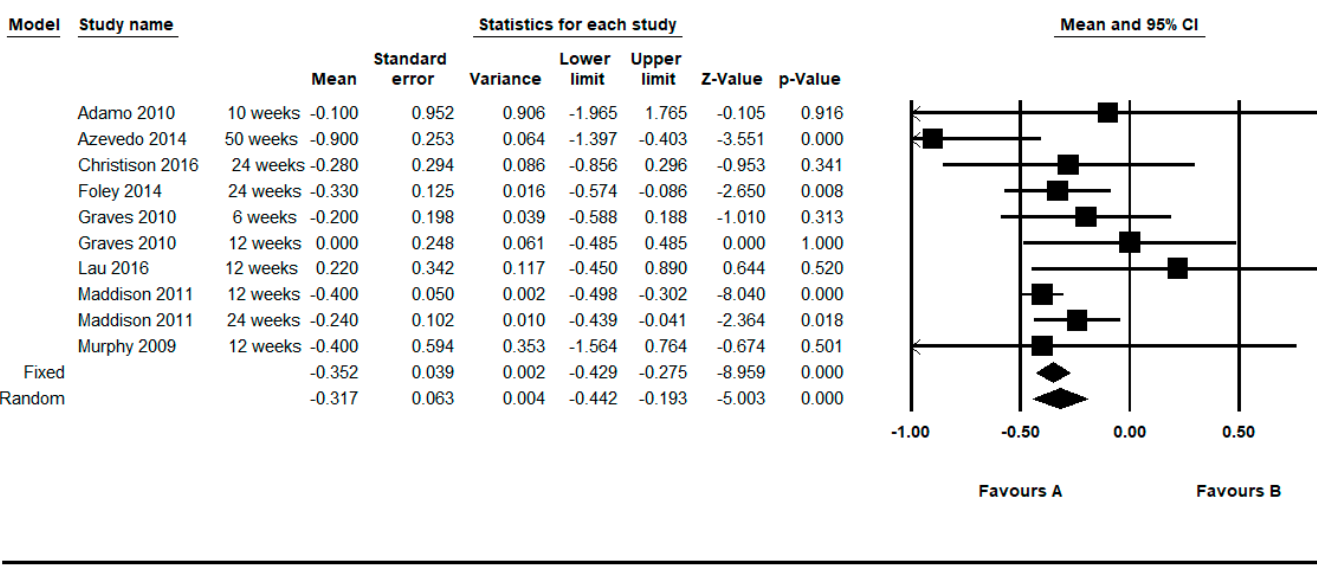
Figure 8. Pre-post difference of BMI between groups. Only BMI (Kgr/m 2 ) and all follow-ups. Table 6. Global heterogeneity between groups. Only BMI (Kgr/m 2 ) and all follow-ups. Difference between Groups. BMI (Kgr/m 2 ).